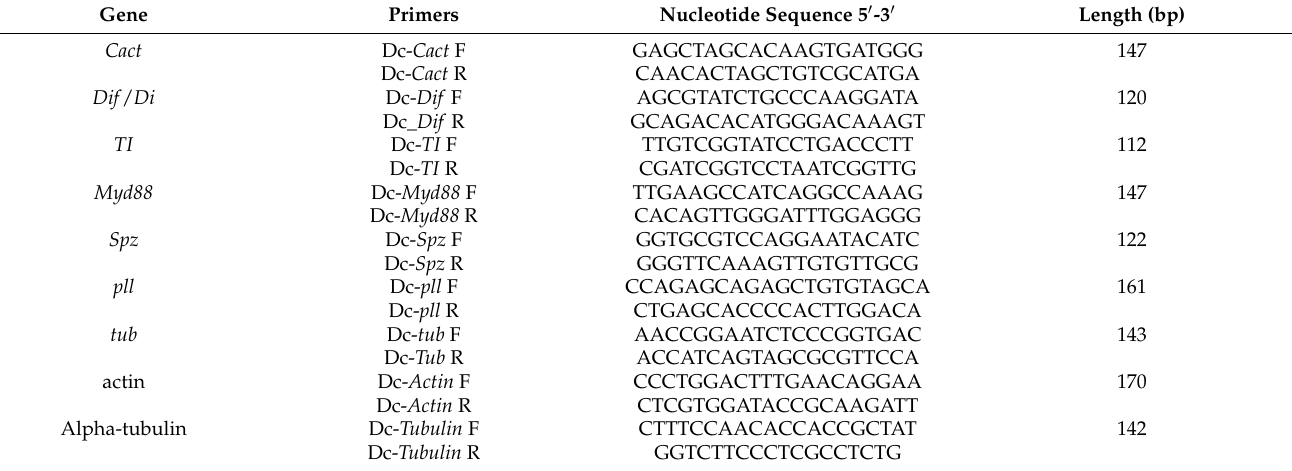
Table 1. List of primers used in this study for gene